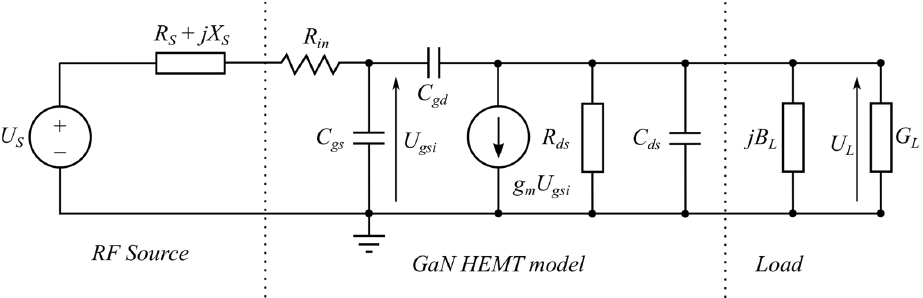
Figure 1. Power amplifier model with GaN high electron mobility transistors (HEMT).